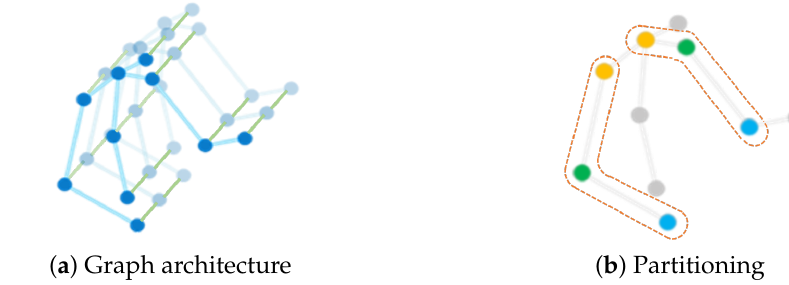
Figure 1. Skeleton graph construction. ( a ) The spatial-temporal graph contains vertexes (blue dots), spatial edges (blue lines), and temporal edges (green lines). ( b ) The dots of different colors in the dashed box represent 3 subsets according to the spatial configuration partitioning strategy, that is, the root node (green), the nodes closer than the root node (yellow), and the nodes farther than the root node from the spinebase joint